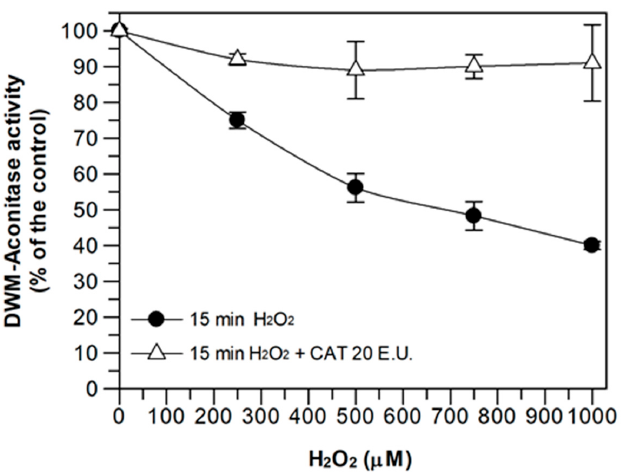
Figure 2. Effect of H 2 O 2 treatment on durum wheat mitochondria (DWM)-aconitase activity, Figure 2. E ff ect of H 2 O 2 treatment on durum wheat mitochondria (DWM)-aconitase activity, evaluated in both the presence and absence of catalase. Measurements were carried out as described in Methods, by incubating DWM proteins (150 µ g) for 15 min in a reaction medium containing 100 mM Tris–HCl pH 8.0, 0.1% ( v / v ) Triton X-100, and di ff erent H 2 O 2 concentrations (250, 500, 750, and 1000 µ M), both in the absence and presence of 20 E.U. catalase (CAT). Aconitase activity values are expressed CAT) and reported as the mean value ± SD ( n = 3). The dependence of DWM-aconitase activity on set of experiments, DWM-aconitase activity under control conditions was equal to 28 ± 2 (SD, n = 3) nmol · min − 1 · mg − 1 of